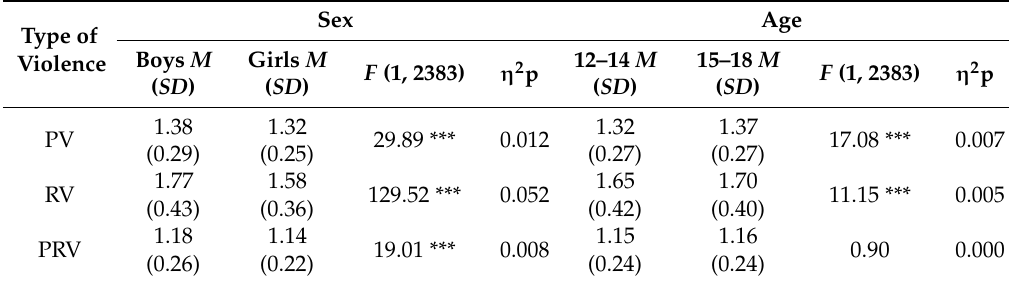
Table 2. Means, standard deviations, and differences on violence by sex and